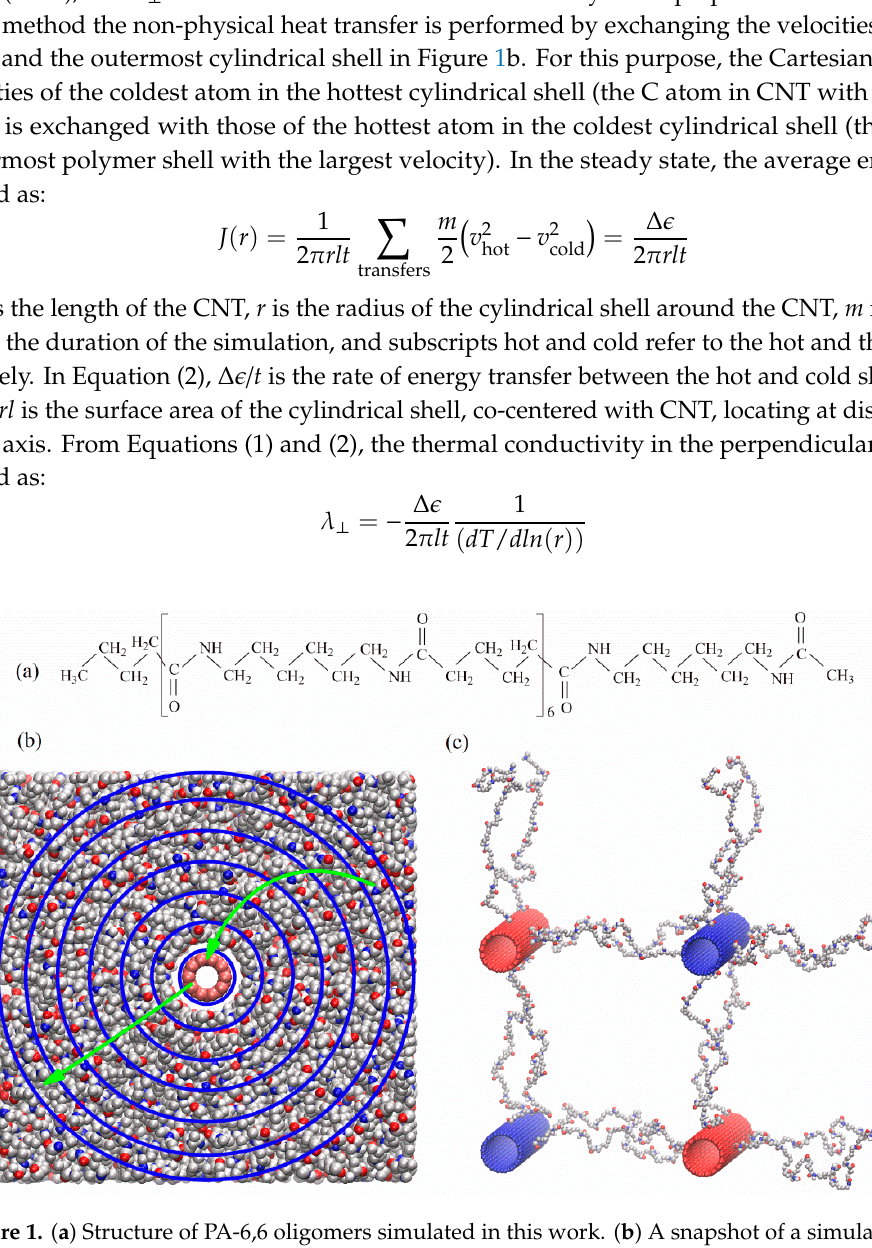
Figure 1. ( a ) Structure of PA-6,6 oligomers simulated in this work. ( b ) A snapshot of a simulation box containing a single CNT (10, 0). The blue, red, grey, and white spheres in the polymer matrix represent N, O, C, and H atoms, respectively. The C atoms of CNT, in the center of box, are shown in red. The curved and straight arrows show the direction of the unphysical heat transfer and the radial heat flow (physical) in the opposite direction, respectively. ( c ) A snapshot of a simulation box containing 4 CNTs (17, 0) laterally linked together via PA-6,6 linkers. For the sake of clarity only CNTs and the linkers are shown. Heat transfer (unphysical) is done from the cold (blue) to the hot red CNTs. In all cases CNTs orient along the z